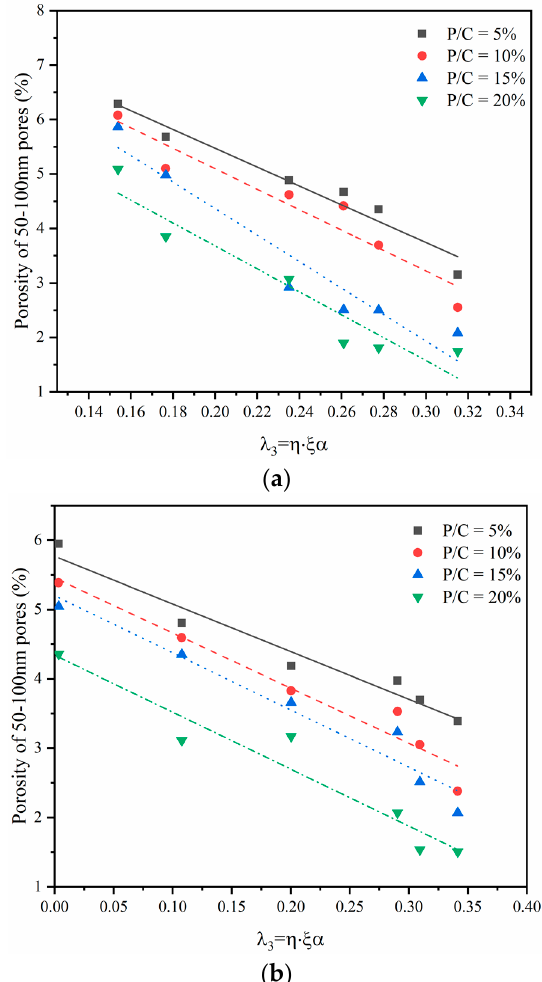
Figure 10. Relationship between the degree of λ 3 and the macropores: ( a ) dry curing and ( b ) wet– dry curing.